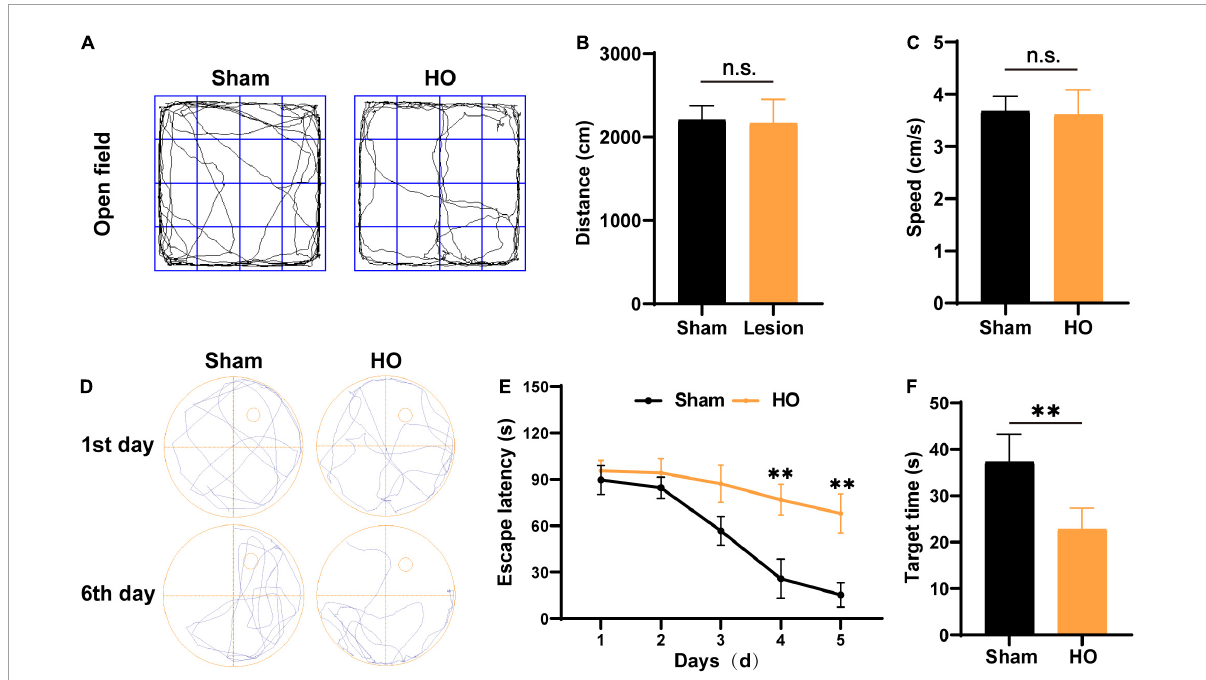
FIGURE2 Verification of the HO rat model using the OP test and MWM test. (A) Movement path in the OP test. (B,C) The total moving distance and movement speed traveled by rats in each group. (D) Swim path in the MWM test. (E) The escape latency of rats in each group, n = 6, ∗∗ P < 0.01 vs. sham-operated group. (F) The latency to reach the original location of the platform of rats in each group, n = 6, ∗∗ P < 0.01 vs. sham-operated group. All data are presented as the M ± SEM of each